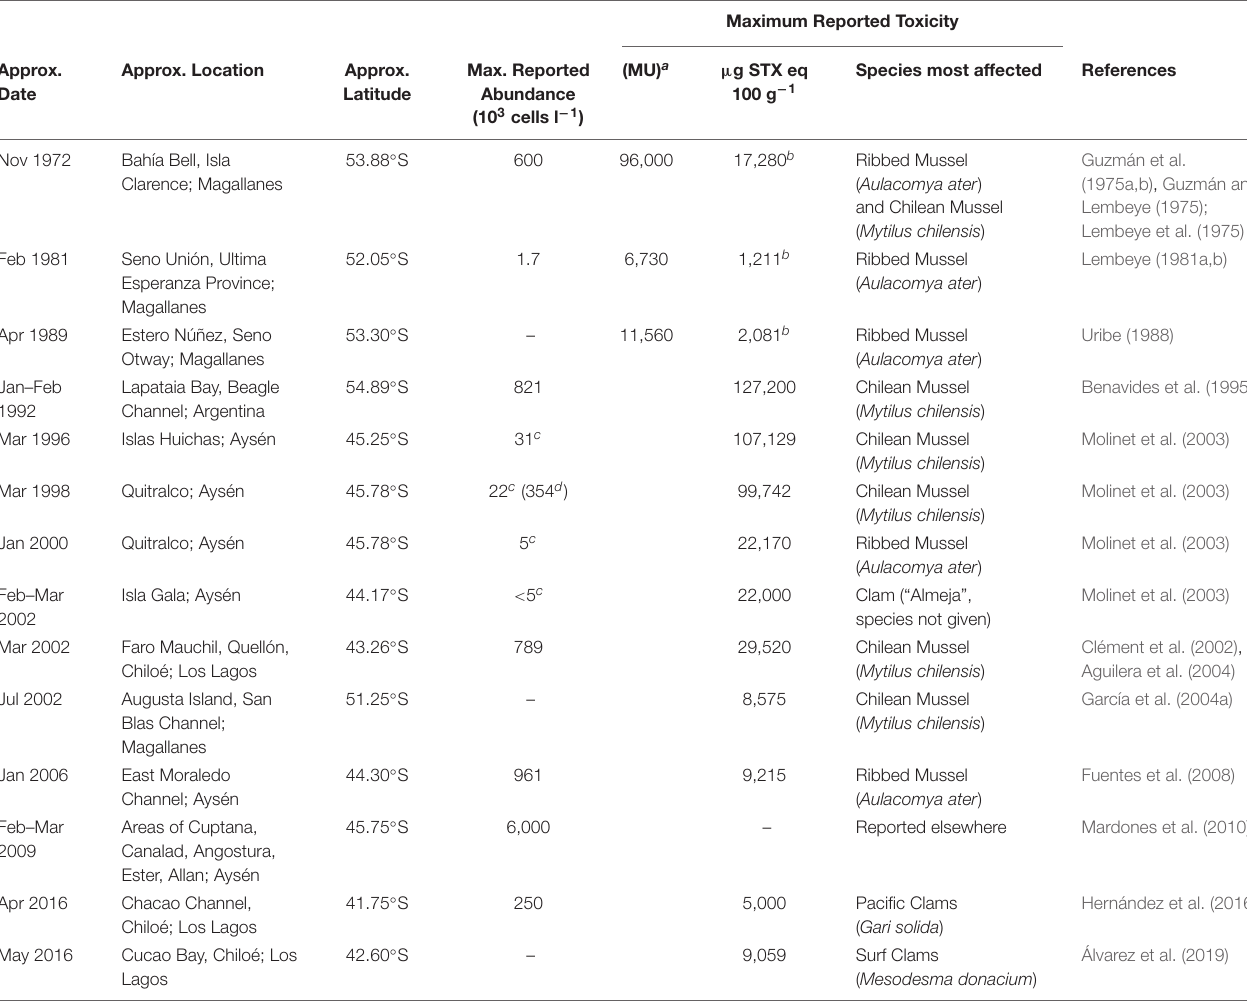
TABLE 1 | Approximate location and timing of the peak of major blooms or toxic events caused by A. catenella in Patagonian and Fuegian coastal waters. Approximate date and position of the focal point of each major event is given, although these blooms and toxic events often extended over much greater areas and periods than indicated below (see individual studies for